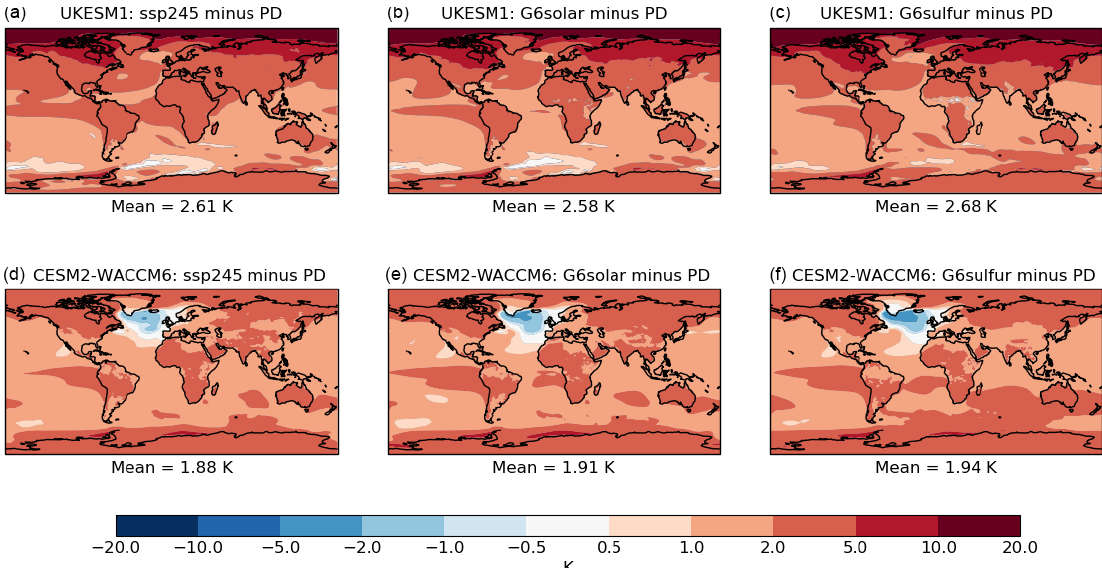
Figure 1. Annual-mean temperature change (K) from present day (PD; 2011–2030 mean) to the end of the century (2081–2100 mean) in the various experiments. Upper row (a, b, c) shows results from UKESM1 and lower row (d, e, f) for CESM2-WACCM6. All results are ensemble means (three members for UKESM1, two for